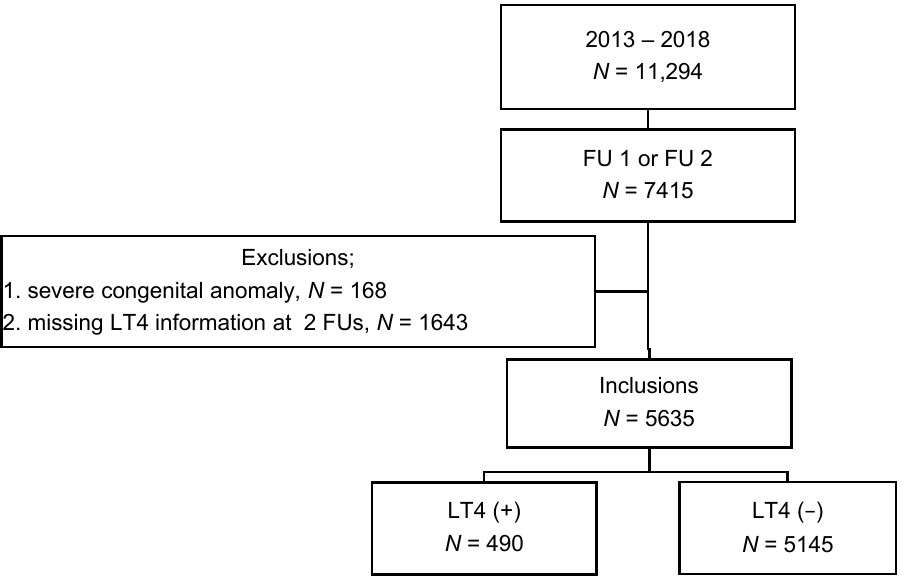
Figure 1. Number of inclusions and incidence of thyroid dysfunction requiring L-thyroxine supple- mentation. Abbreviations: FU1, follow-up visit at 18–24 months of corrected age; FU2, follow-up